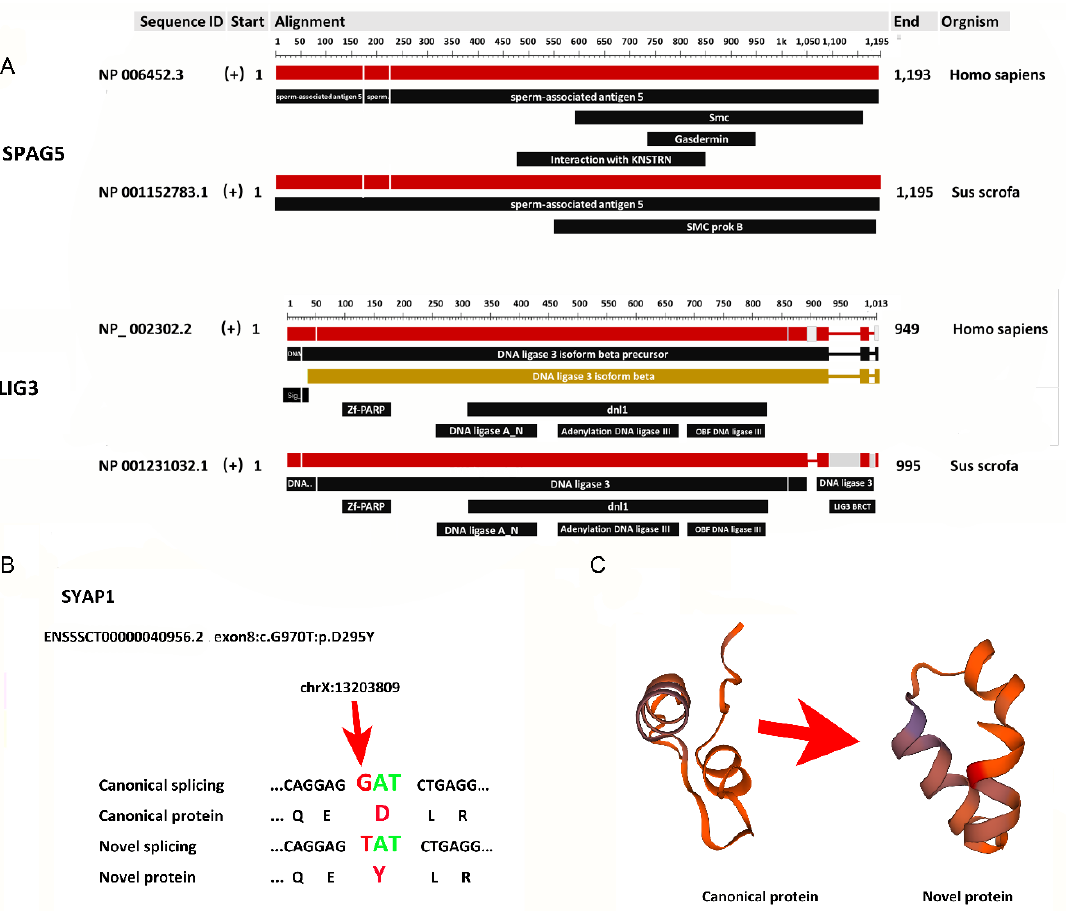
Figure 5. ( A ) Example of a homologous protein related to an AS gene between human and pig (downloaded from NCBI Multiple Sequence Alignment Viewer, Version 1.15.0). ( B ) Effect of single nucleotide polymorphism (SNP) mutation of synapse-associated protein 1 (SYAP1) on alternative splicing. ( C ) Protein conformation of canonical and novel isoforms as predicted by the Swiss model.